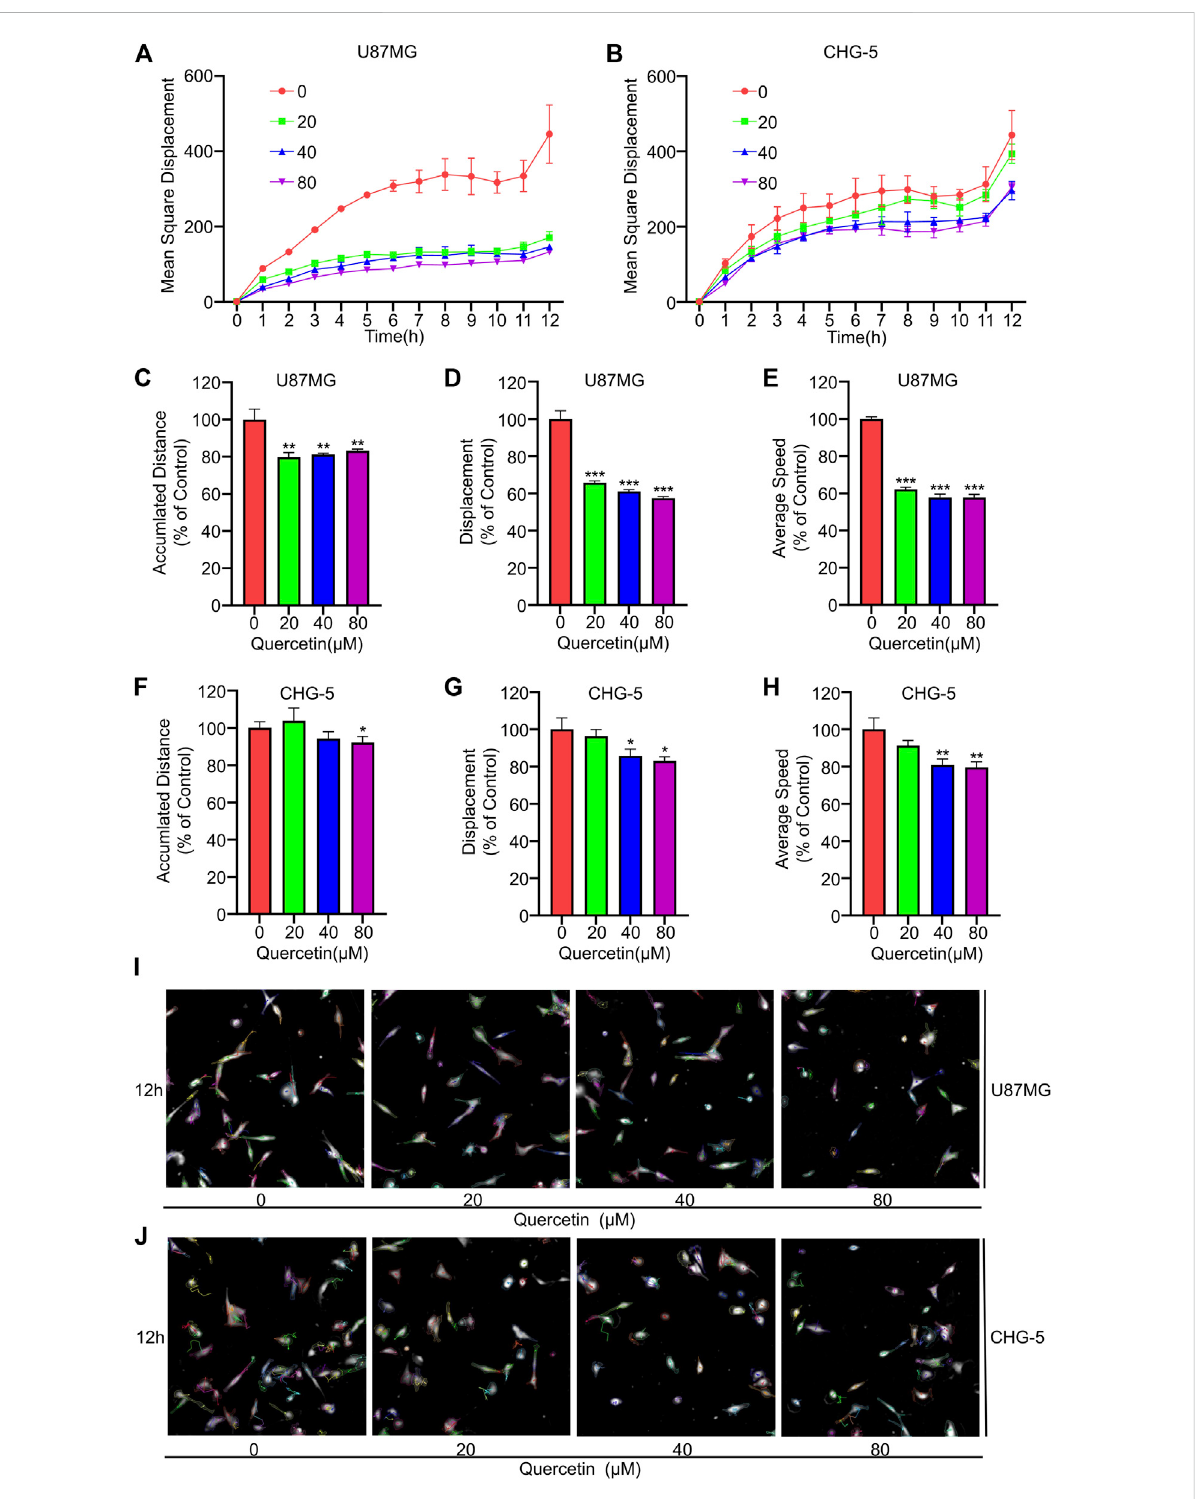
FIGURE 2 Effect of Quercetin on spontaneous movement of glioblastoma cells using high content analysis. U87MG and CHG-5 cell lines were incubated with various concentrations of Quercetin (0, 20, 40, 80 μ M) for 12 h in serum free medium. Digital phase contrast (DPC) images are taken every 1 h on PerkinElmer Operetta for 12 h. Mean square displacement (A,B) , accumulated distance (C – F) , displacement (D – G) and average speed (E – H) accumulated over time for all cells were quanti fi ed and presented. Harmony 4.9 software was used to track cell displacement, and representative cell tracking images (I,J) were given. All data are shown as the mean ± SD of three experiments. * p ＜ 0.05, ** p ＜ 0.01 or *** p ＜ 0.001 vs. control